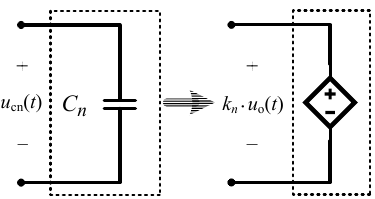
Figure 2. Equivalent circuit of a capacitor where a controlled voltage source is used to replace the VM capacitor.